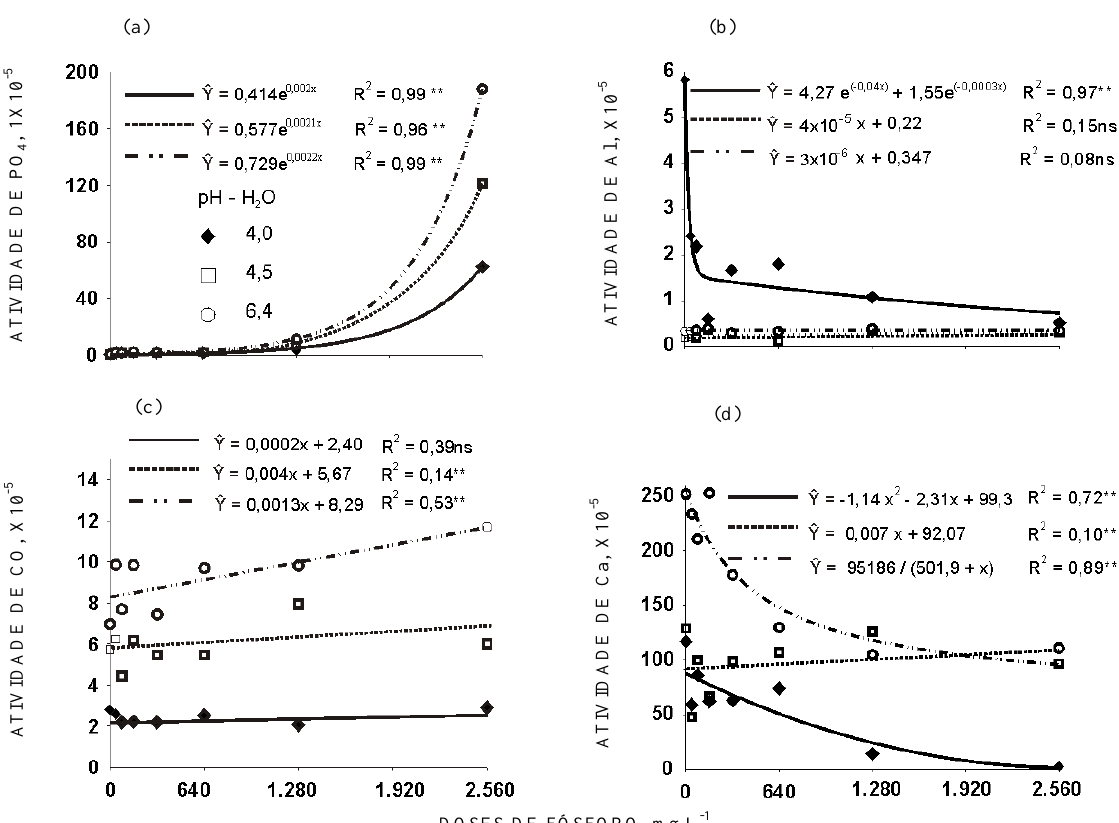
DOSES DE FÓSFORO, mg L